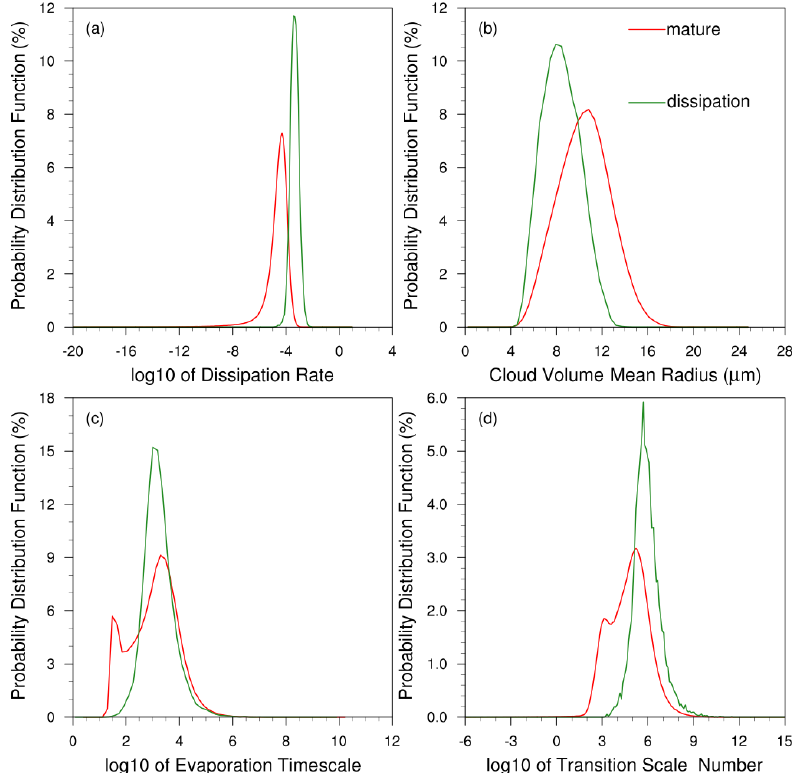
Figure 7. Probability distribution functions (PDFs) of (a) turbulence dissipation rate ( ε ), (b) cloud droplet volume mean radius ( r v ), (c) evap- oration timescale ( τ evap ), and (d) transition scale number ( N L ) of cloud grids experiencing the entrainment–mixing process at the mature stage from 12:00 to 16:00UTC (the red lines) and the dissipation stage from 21:00 to 24:00UTC (the green lines) in new for the stratocumulus case. The experiment is detailed in Table